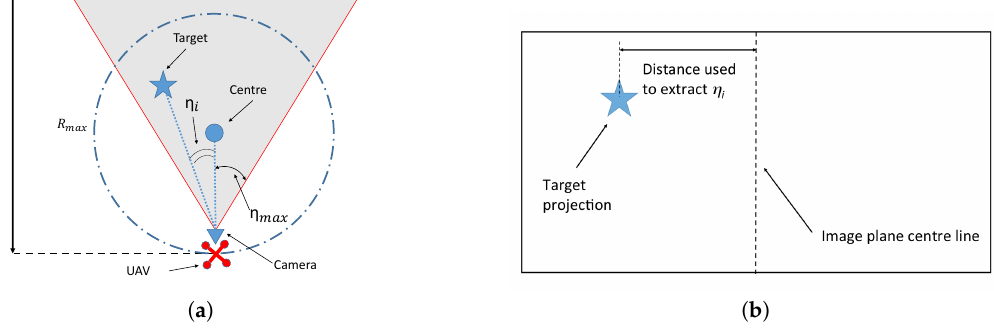
Figure 1. ( a ) Bird’s eye view of the i -th drone placed on the circle. The shaded grey area represents the limited field-of-view (FOV) of the camera, while η max is the maximum value of the measurable bearing. ( b ) Image seen from the i -th drone.